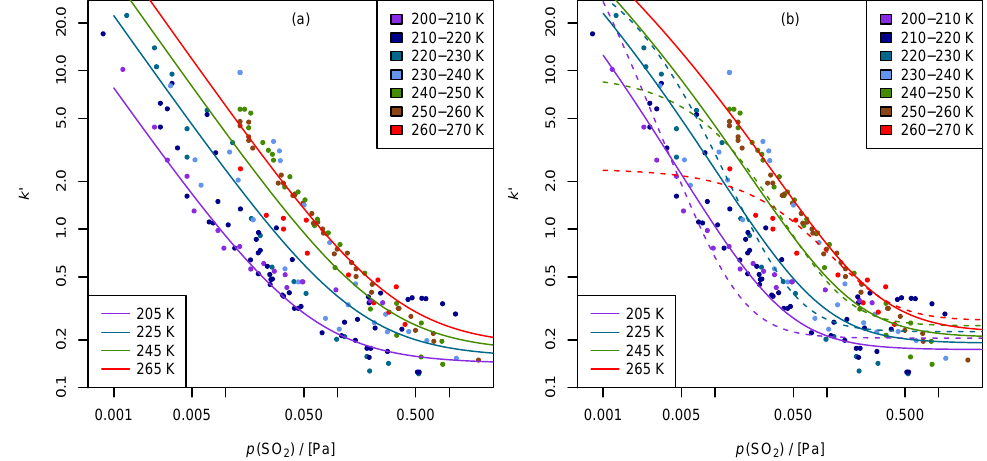
Figure 3. Double logarithmic plot of k (cid:48) vs. p( SO 2 ) at peak maximum for experiments with ice film thickness h > 4µm and without ice aging. (a) Fit with Temkin adsorption isotherm according to Eq. (8). (b) Fit with simple Langmuir model (dashed lines) according to Eq. (11) and with the dissociative Langmuir model (solid curves) according to Eq. (17).